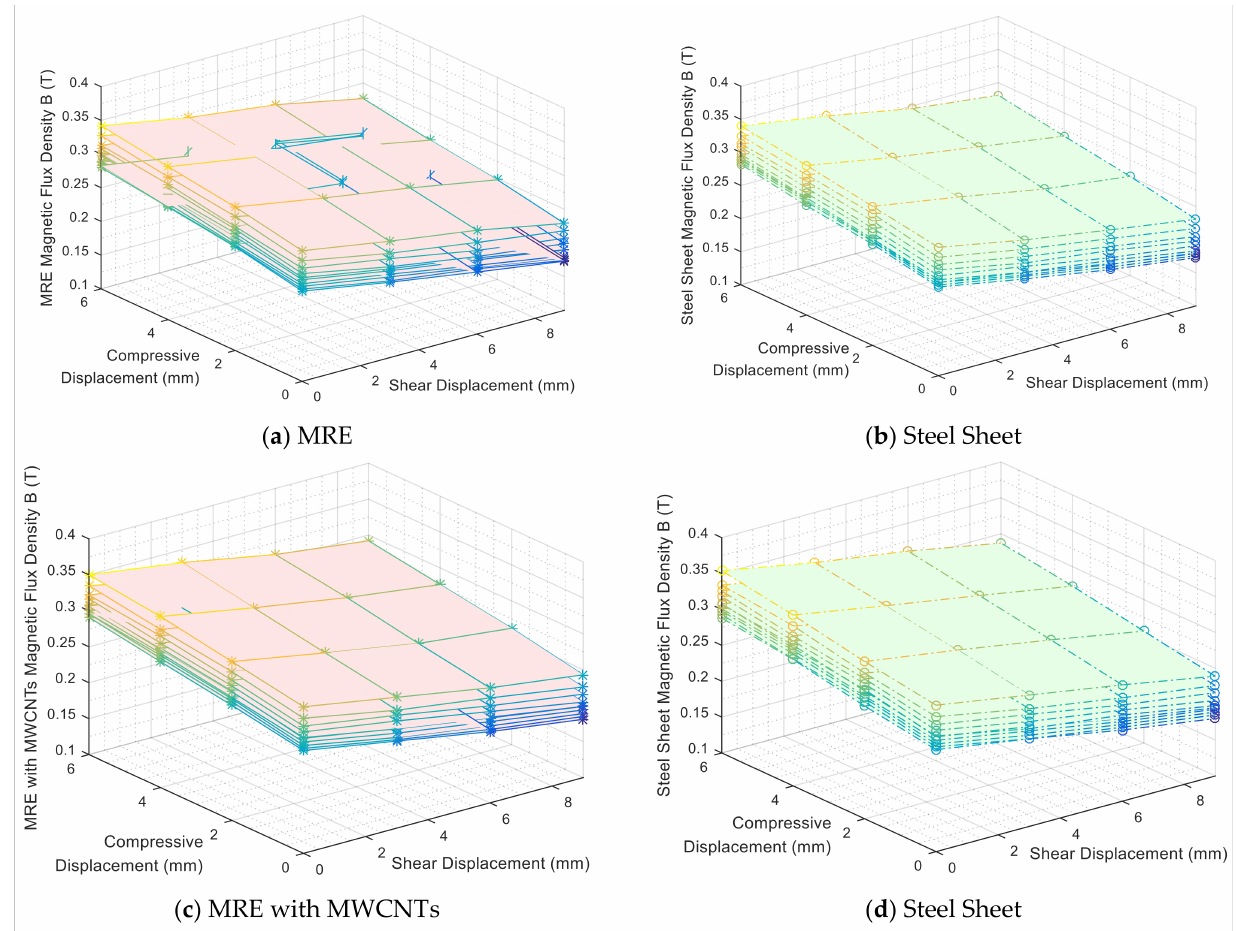
Figure 15. Magnetic Flux Density under Shear and Compressive